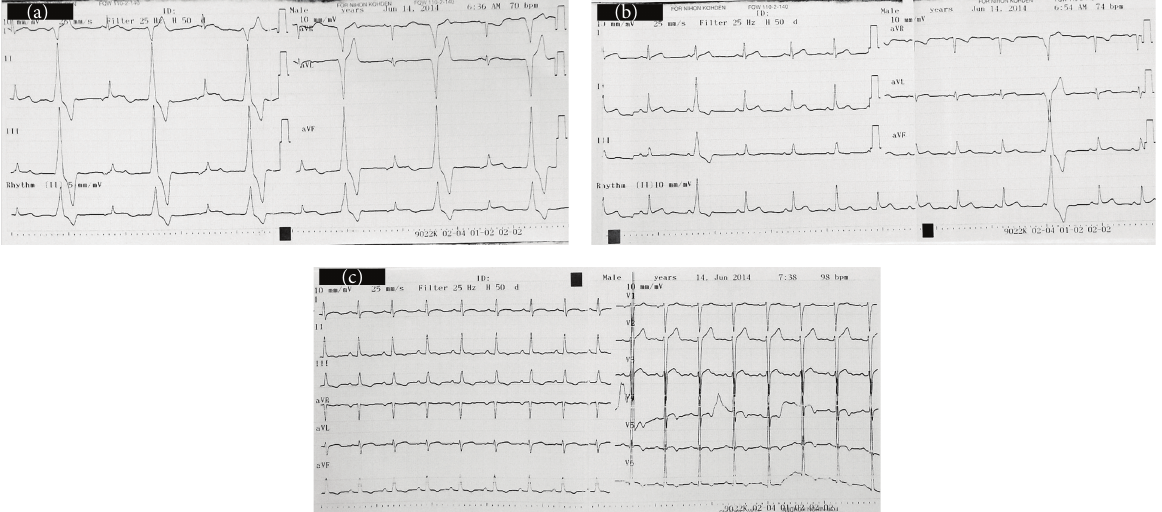
Figure 4: (a) Initial (before ILE treatment) electrocardiography of Case 4 with accelerated junctional rhythm concomitant with bigeminy ventricular extrasystoles. (b) Electrocardiography of Case 4 after bolus administration of intravenous lipid emulsion (5th minute of ILE). (c) Electrocardiography of Case 4 after intravenous lipid emulsion infusion (60th minute of